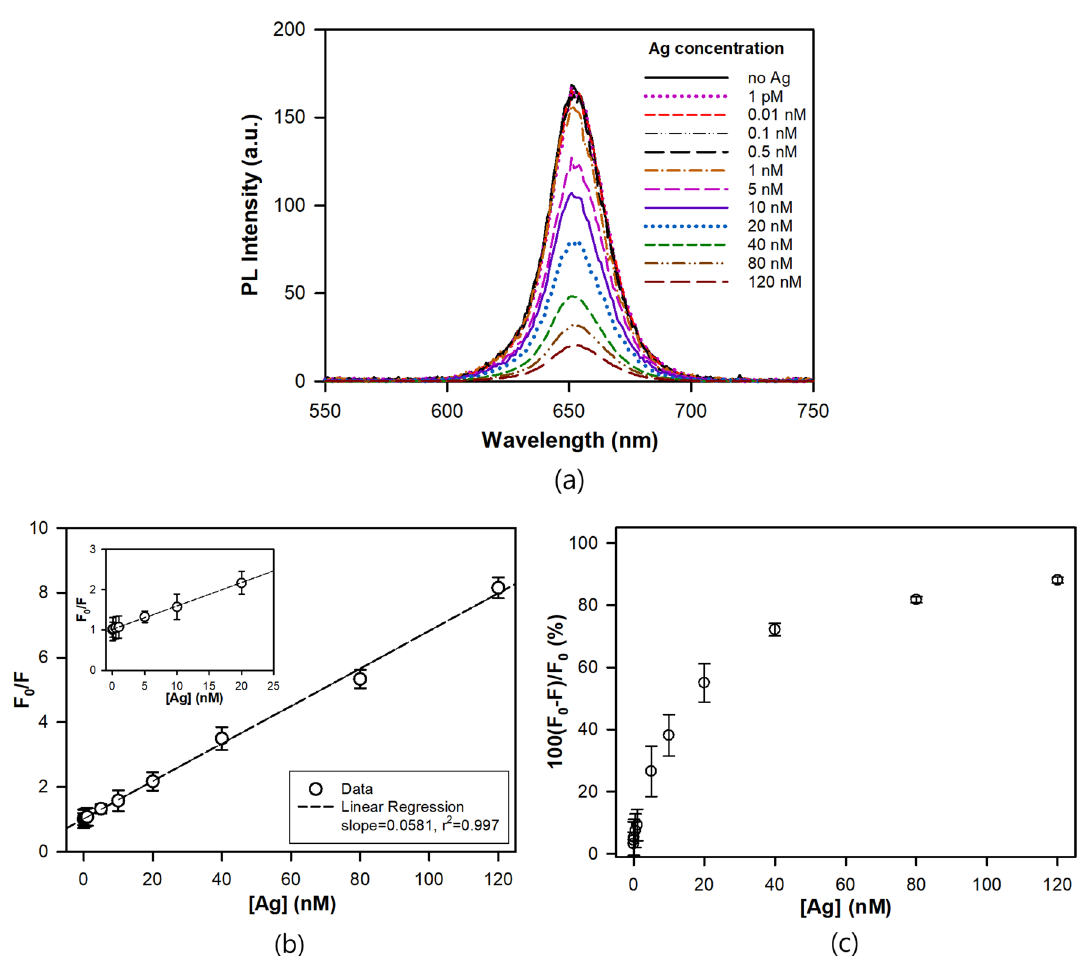
Figure 5. ( a ) PL emission spectra, ( b ) Stern–Volmer plot, and ( c ) quenching efficiency upon conjugation of QDs/SA-Ab with Ag at different Ag concentrations from 0.001 to 120